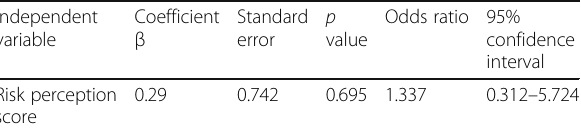
Table 4 Distribution of the number of occupational accidents in the injured foundry workers ( N = 51) in Tehran, Iran, 2016 Occupational accident